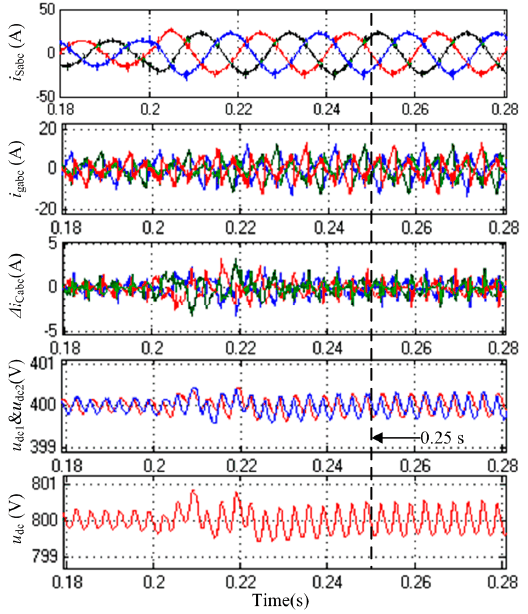
Figure 10. Dynamic response of NPC-SAPF when λ = − 1 × 10 − 2 .